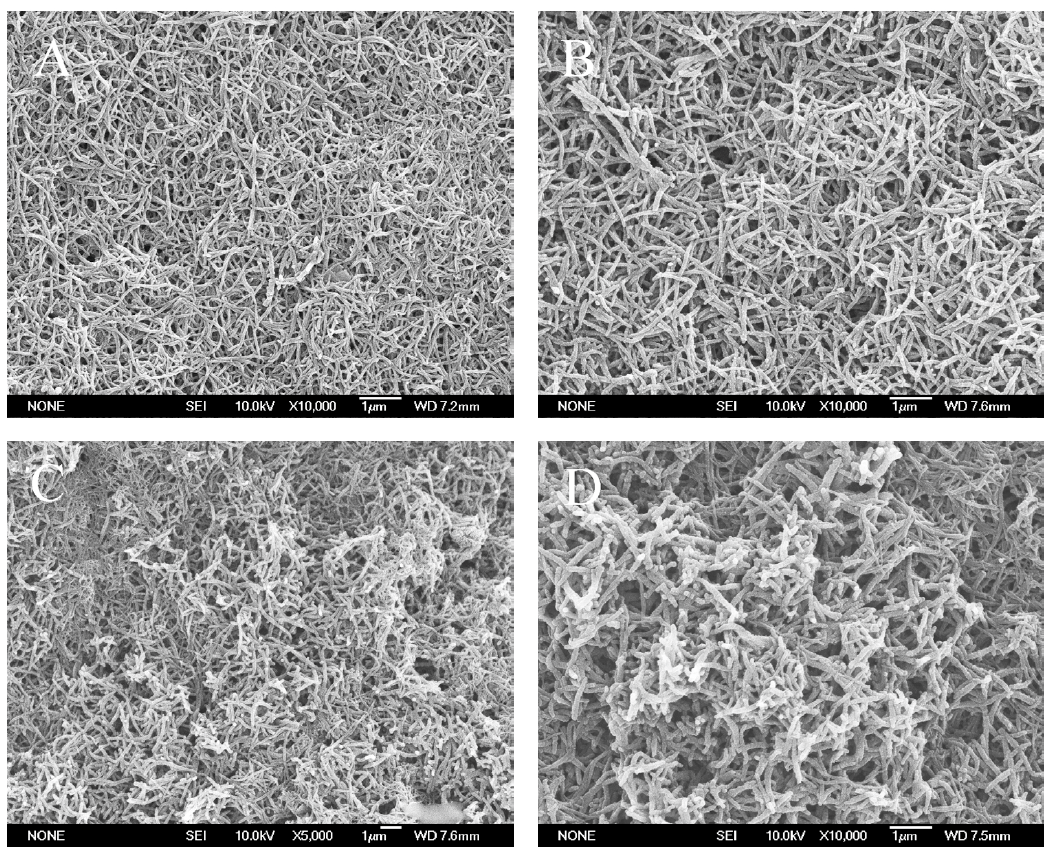
Figure 4. SEM images of PANI nanofibers prepared with various electrode areas ( A ) 0.08 m × 0.085 m; ( B ) 0.10 m × 0.10 m; ( C ) 0.10 m × 0.50 m; ( D ) 0.10 m × 1.00 m [169].